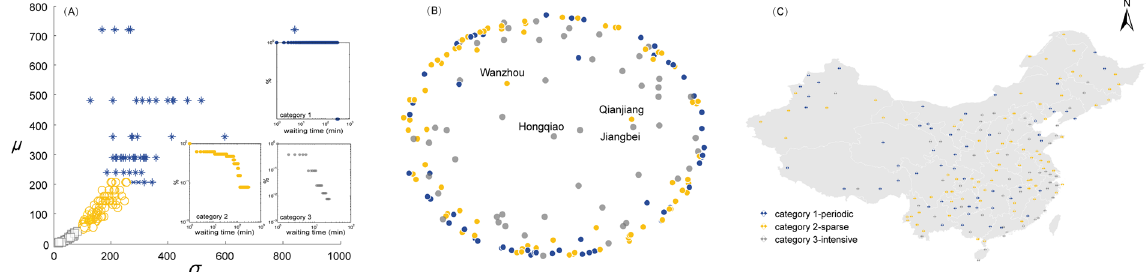
Figure 3. Airport classification based on burstiness. ( A ) Clustering based on the standard deviation ( σ ) and the mean ( μ ) of the waiting time between consecutive flights. Examples for each class are shown in the insets– Chengdu Shuangliu Airport for category one, Daqing Saertu Airport for category two and Kuqa Airport for category three. ( B ) Distribution of airports using a chart based on the GDP of the relevant cities. The center represents Hongqiao Airport and the radius denotes the gap between the GDP of Shanghai (the richest city in China) and other cities. ( C ) Spatial distribution of airports by category (mainland in China). The map is obtained from OpenStreetMap.org under the Open Data Commons Open Database License (ODbL), and visualized with ArcGIS 10.0 (http://www.esri.com/).